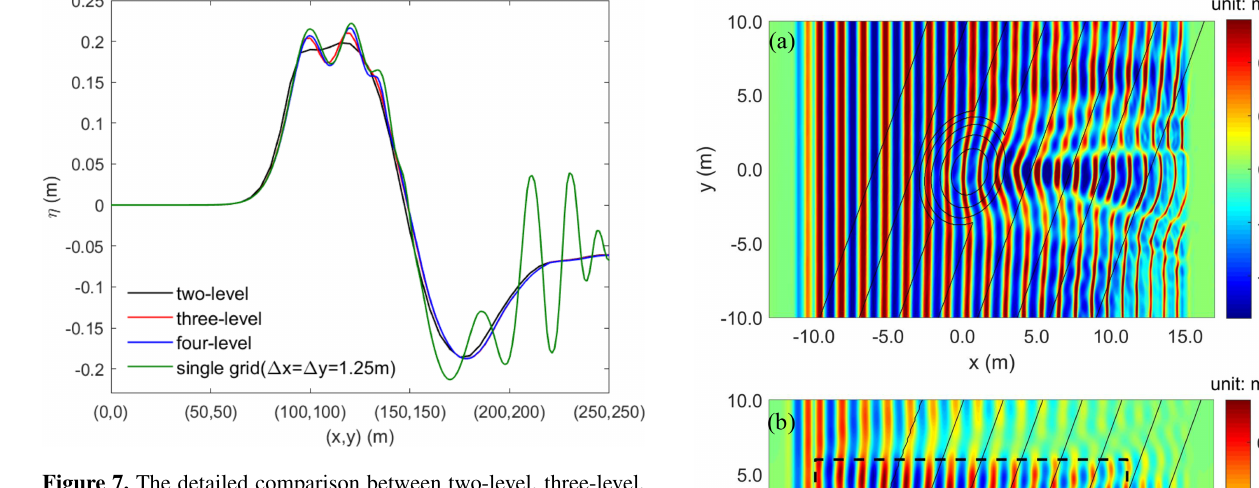
Figure 7. The detailed comparison between two-level, three-level, and four-level grids and single higher-resolution grid configurations along the transect crossing ( 0 , 0 ) – ( 250 , 250 ) m.